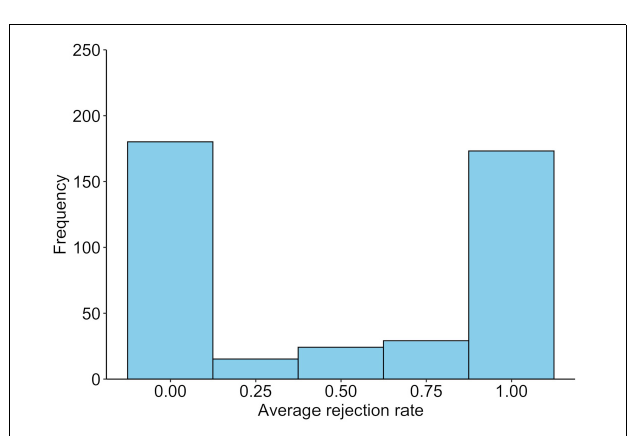
FIGURE 4 | Distribution of the behavioral responses to unfair distribution in the third-party punishment game. The average punishment amount for unfair distribution in the third-party punishment